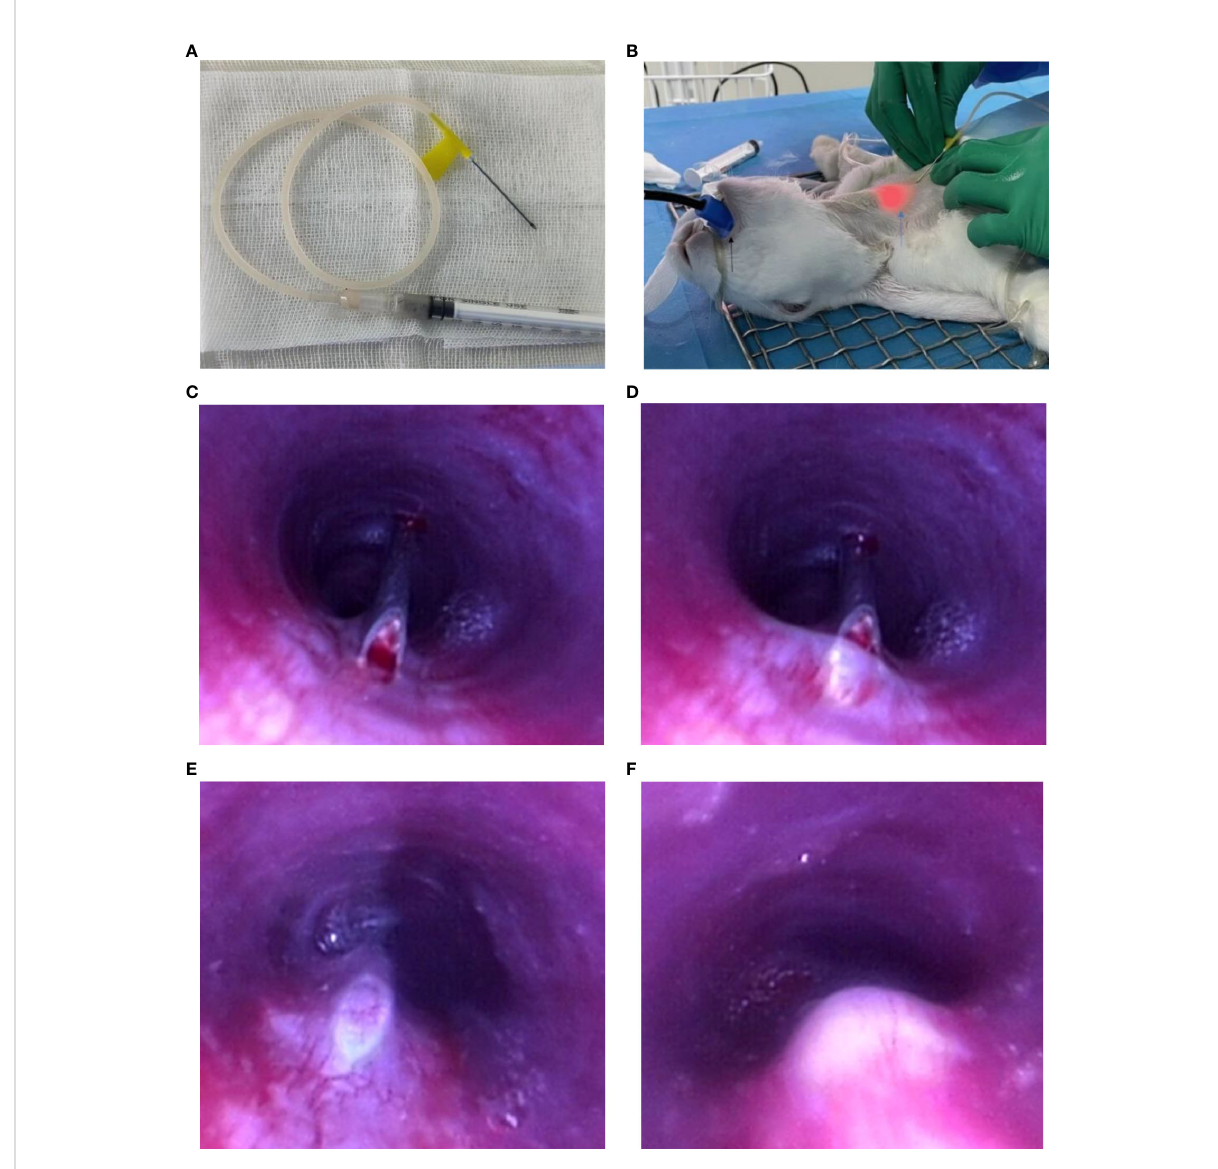
FIGURE 1 Endoscopic implantation of VX2 fragment suspension. Preparation before implantation: (A) VX2 fragment suspension in a 1-ml syringe connecting with a 20-gauge transfusion needle. (B) The black arrow points to the medical tooth pad; blue arrow points to the light source of the bronchoscope; Procedure of endoscopic implantation: (C – E) The 20-guage needle entering into the submucosal layer. (F) Injection of VX2 fragment